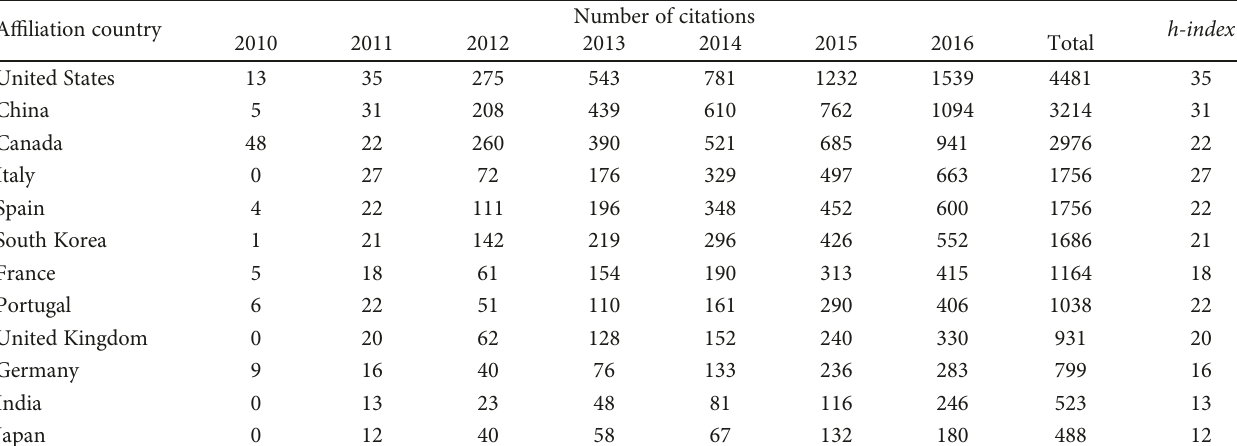
Table 12: Number of citations and h-index for selected countries ranked by total number of citations between 2010 and 2016 for the same search term.